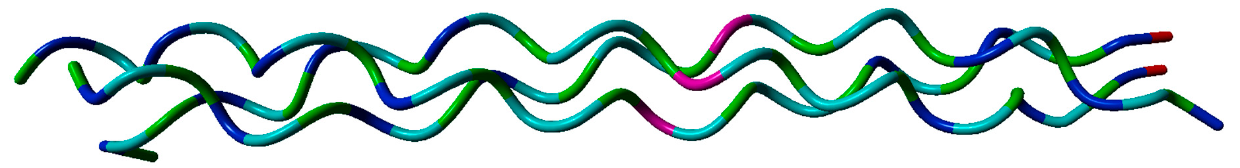
( d ) Figure 4. The influence of deacetylation on the stability and selected structural features of collagen– chitosan complexes. ( a ) Affinity energy vs. deacetylation degree (DD) of chitosan. ( b ) Number of intermolecular H-bonds vs. deacetylation degree (DD) of chitosan. ( c ) Number of intermolecular hydrophobic (HP) interactions vs. deacetylation degree (DD) of chitosan. ( d ) Number of intermo- lecular ionic interactions vs. deacetylation degree (DD) of chitosan. The green line represents the average affinity energy value determined for the collagen-HA system. As one can see from Figures 4b,d, there is a very weak correlation between the num- ber of ionic interactions and DD (R 2 = 0.22) and practically no correlation in the case of the number of hydrogen bonds vs. DD plot (R 2 = 0.01). This is understandable as the number of intermolecular interactions is only a very rough measure of the stability of macromo- lecular complexes [90]. On the other hand, the stability of collagen self-assemblies is re- lated to the number of intermolecular interactions, mainly hydrogen bonds and electro- static interactions [10,91,92]. It is worth emphasizing that both interactions are character- ized by the highest contribution to the binding energy. When the DD is higher than 0.3,